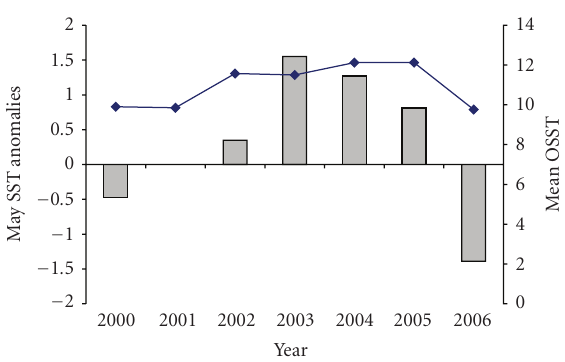
Figure 2: May sea surface temperature (SST) anomalies (bar, ◦ C) during 2000 to 2006 in the southeastern Bering Sea (data obtained from http://www.beringclimate.noaa.gov/) and annual averages (line) of observed SSTs (OSST, ◦ C) collected during August to early September surveys. Mean May SSTs are averaged over the area 54 ◦ 18 (cid:3) N to 60 ◦ 0 (cid:3) N, 161 ◦ 12 (cid:3) W to 172 ◦ 30 (cid:3) W using data from the NCEP/NCAR reanalysis project [37]. The May SST anomalies are the deviations from the mean May SST value (2 . 33 ◦ C) for the 1970–2000 period normalized by the standard deviation (0 . 76 ◦ C). Mean OSSTs ( ◦ C) are the averages of observed SSTs at 5 m depth taken at stations conducted within the survey area of Figure 1.